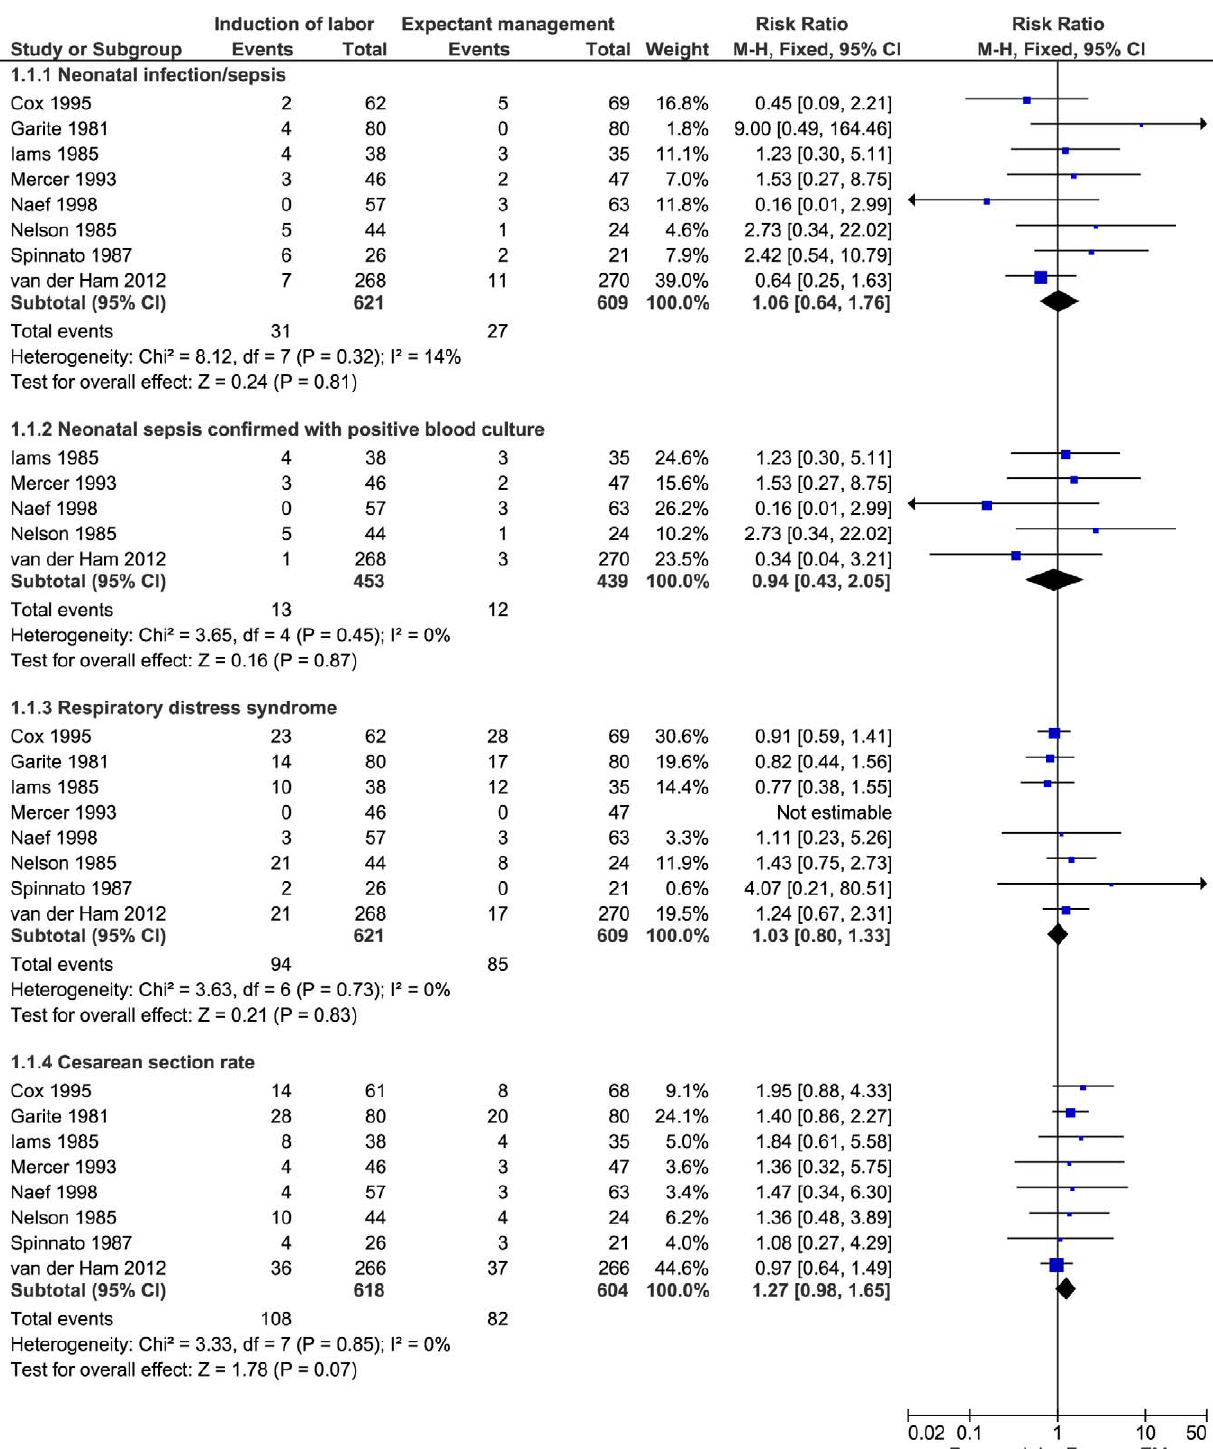
Figure 3. Meta-analysis. Risk ratio according to Mantel-Haenszel (M–H) with fixed effects and 95% CIs for neonatal sepsis, culture-proven neonatal sepsis, RDS, and cesarean section rates.